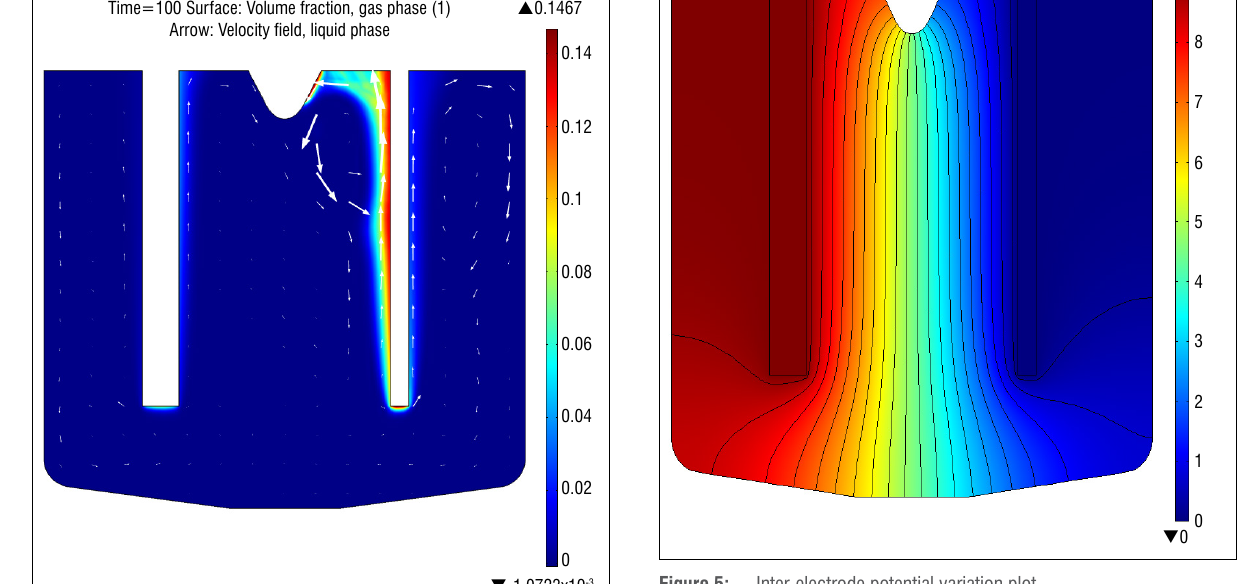
Figure 5: Inter-electrode potential variation plot.